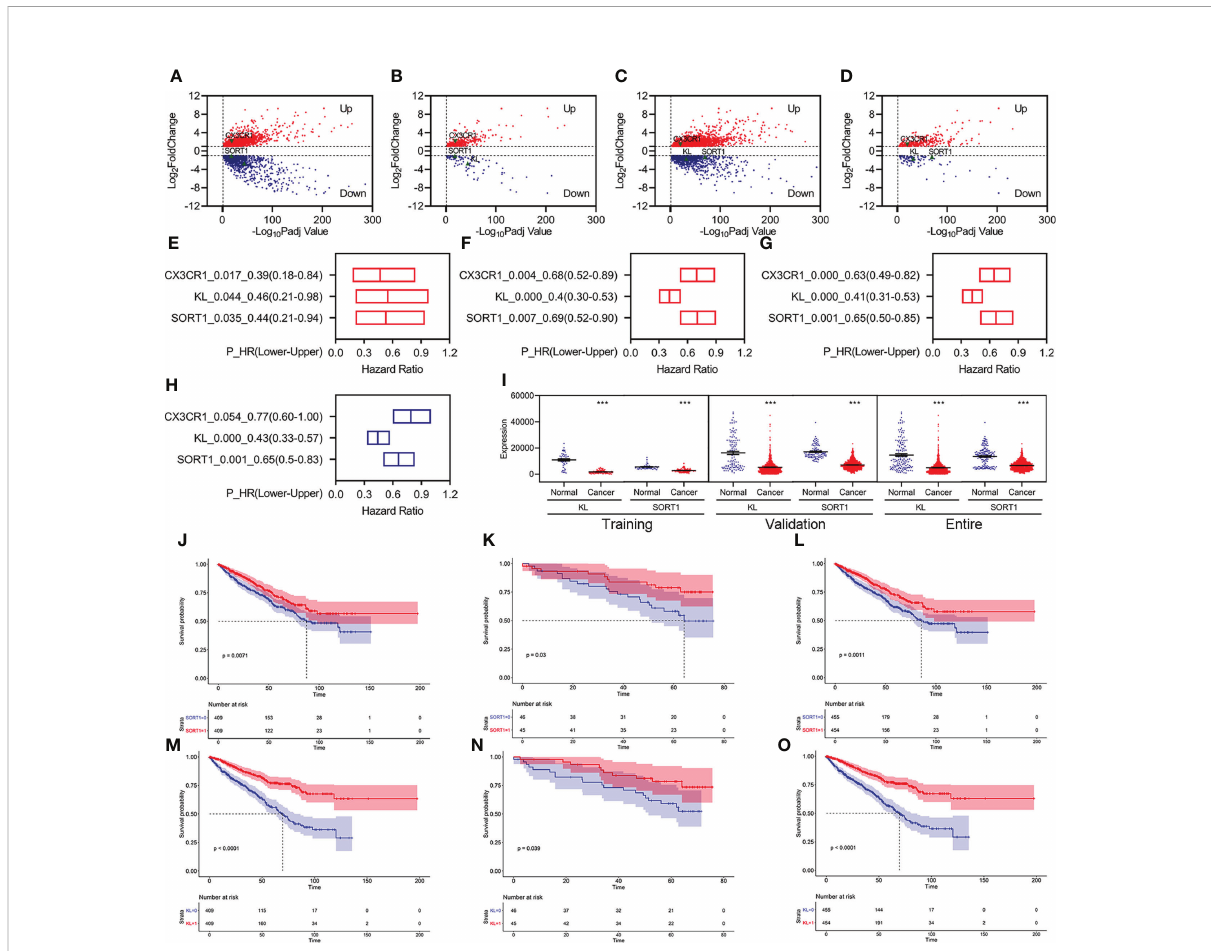
FIGURE 2 Identi fi cation of prognosis-related FI-DEGs. (A, B) Volcano plots of DEGs (A) and FI-DEGs (B) for KC in the training group. (C, D) Volcano plots of DEGs (C) and FI-DEGs (D) for KC in the validation group. (E – G) OS-related FI-DEGs identi fi ed by univariate Cox regression analyses in the training group (E) , validation group (F) , and entire group (G) . (H) OS-related FI-DEGs identi fi ed by multivariate Cox regression analyses in the entire group. (I) Expressions of KL and SORT1 in the training, validation, and entire groups. (J – L) KM curve of SORT1 in the training group (J) , validation group (K) , and entire group (L) . (M – O) KM curve of KL in the training group (M) , validation group (N) , and entire group (O) . ***p <